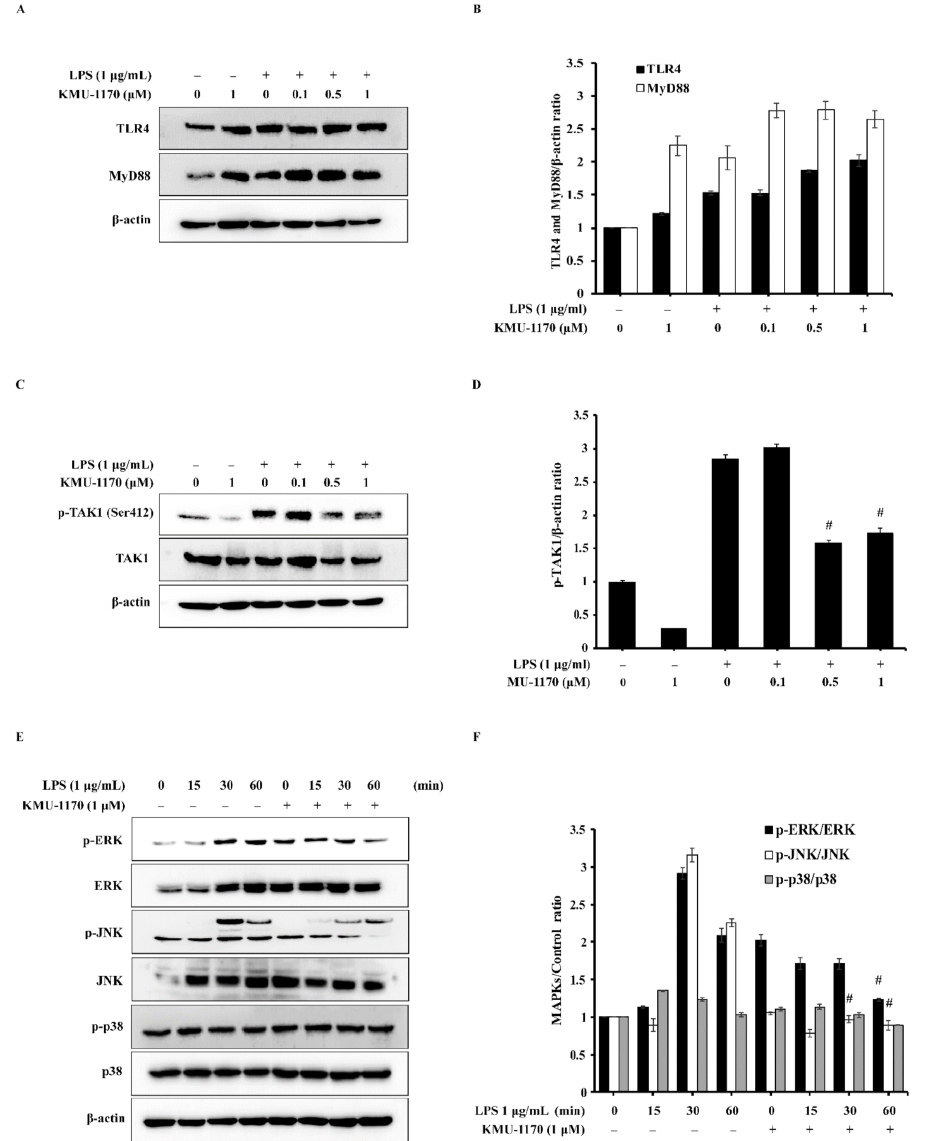
Figure 3. Effect of KMU-1170 on LPS-TLR4 signaling pathway-related proteins in THP-1 cells. ( A , C ) Cells were differentiated into macrophages for 24 h using PMA (100 nM). And then the cells were treated with LPS (1 µ g/mL) for 6 h after pretreatment with different doses of KMU-1170 (0.1, 0.5, and 1 µ M) for 1 h. Whole cell lysates were isolated and used to measure the protein expression levels of TLR, MyD88, and β -actin by Western blot analysis ( A ). ( B ) Image-J software was used to analyze the relative optical density of the TLR4 and MyD88 band. Whole cell lysates were isolated and used to measure the protein expression levels of p-TAK1, TAK1, and β -actin by Western blot analysis ( C ). ( D ) Image-J software was used to analyze the relative optical density of the p-TAK1 band. ( E ) Cells were differentiated into macrophages for 24 h using PMA (100 nM), then the cells were treated with or without 1 µ M KMU-1170 for 24 h and stimulated with LPS (1 µ g/mL) at the indicated times. Whole cell lysates were isolated and used to measure the protein expression levels of p-ERK, ERK, p-JNK, JNK, p-p38, p38, and β -actin by Western blot analysis. ( F ) Image-J software was used to analyze the relative optical density of the p-ERK, p-JNK, and p-p38 band. # p < 0.001 compared to LPS